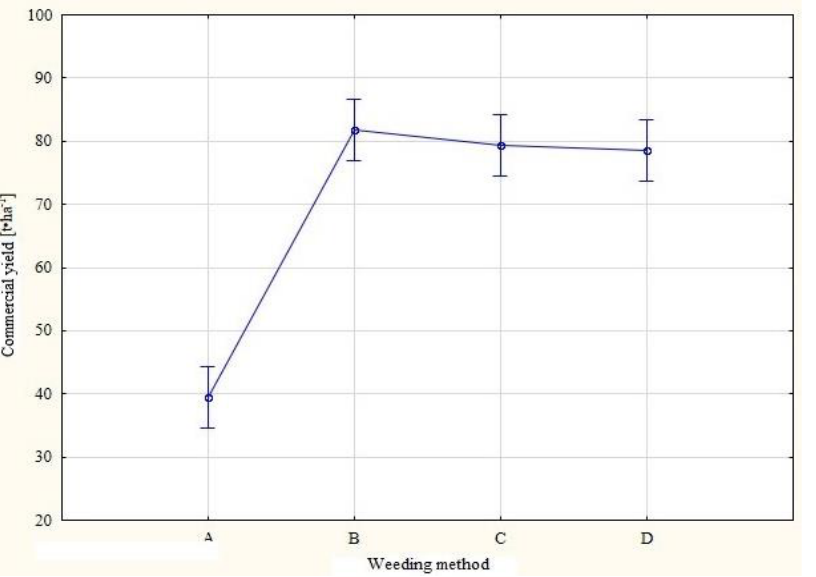
Figure 5. Expected marginal averages for 0.95 confidence intervals in commercial onion yield in 2016 (source: own work).